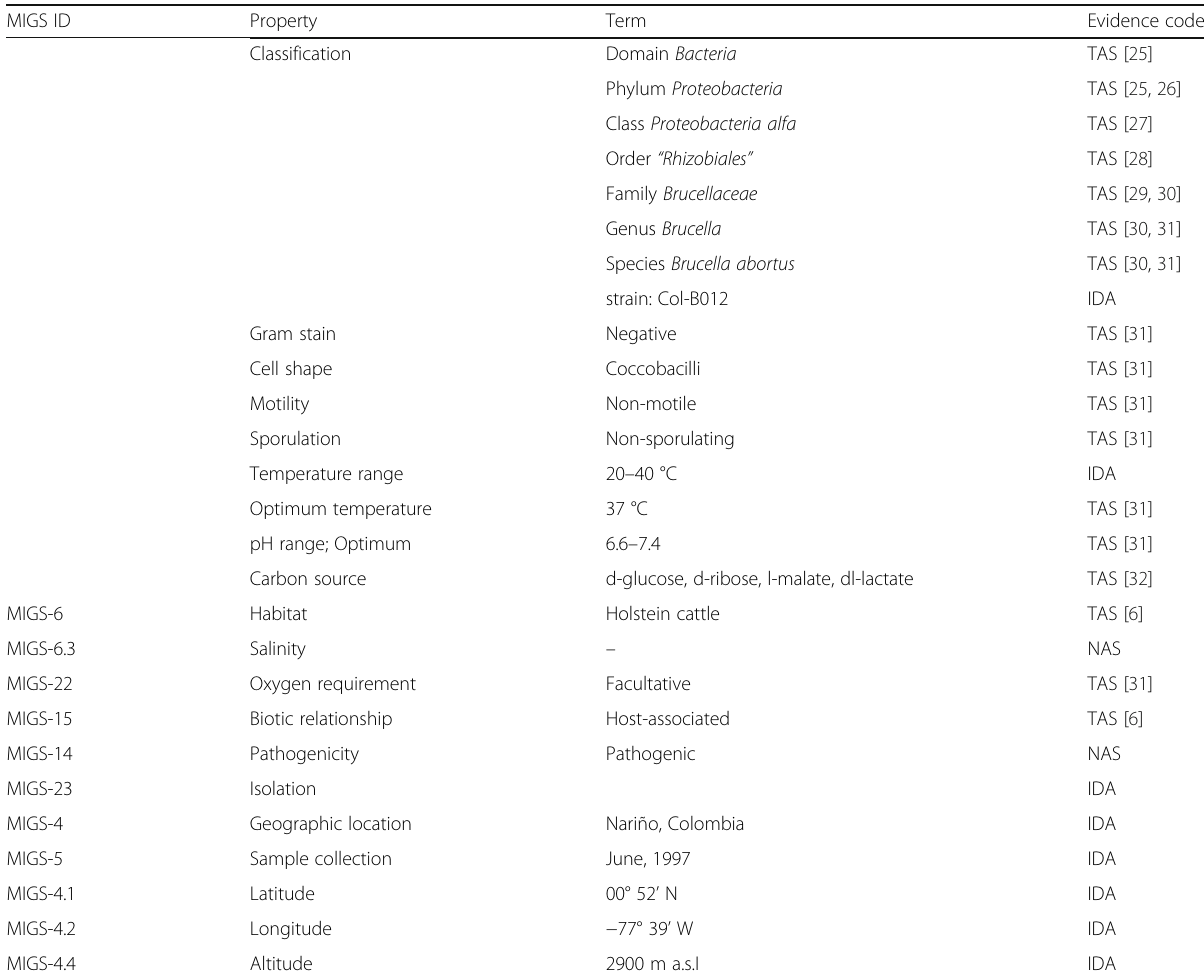
Table 1 Classification and general features of B. abortus strain Ba Col-B012 MIGS ID